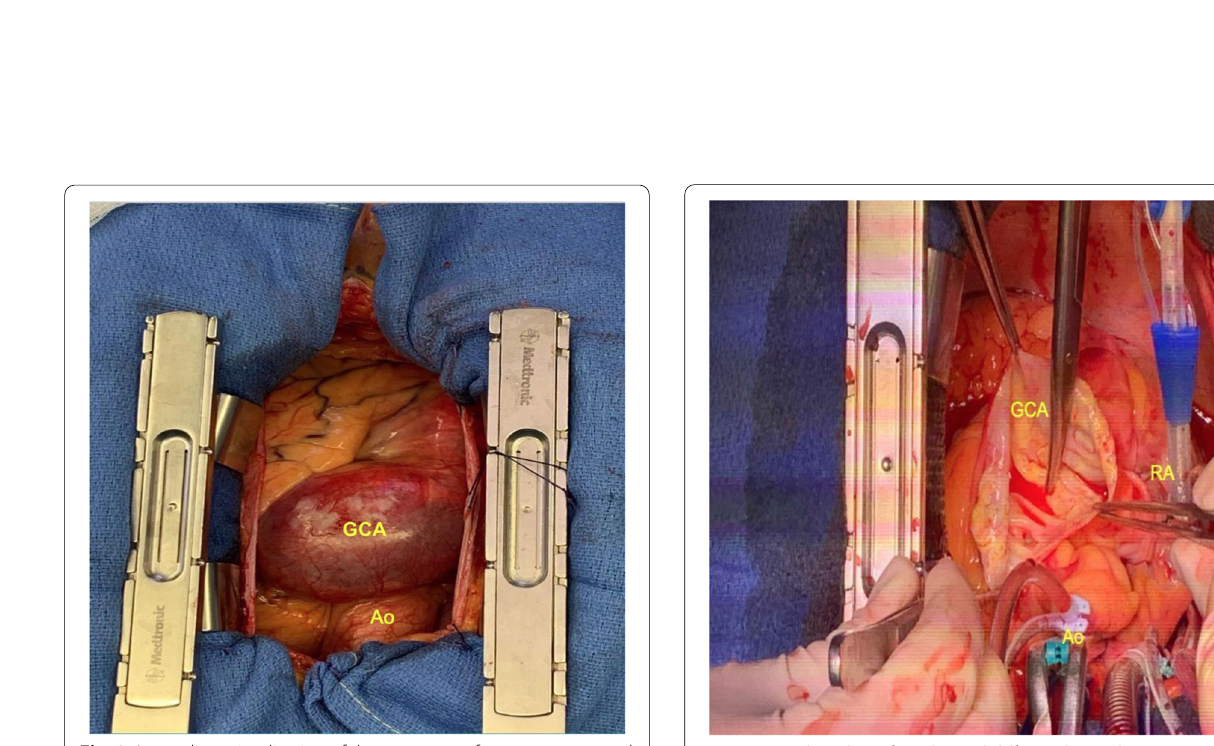
Fig. 4 Complete deroofing showed diffuse atherosclerosis. GCA, giant coronary aneurysm; Ao, aorta ascendens; RA, right